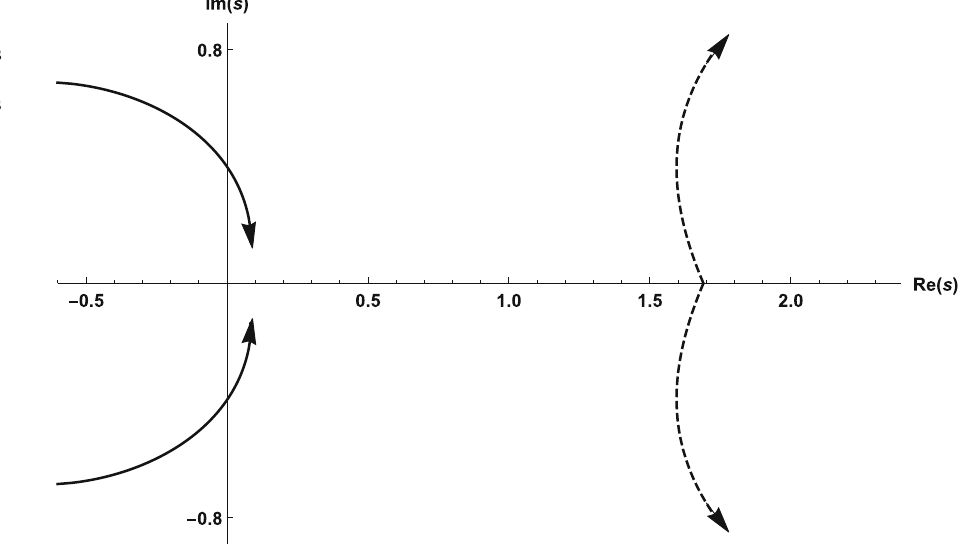
Fig. 4 Trajectories of the two poles related to the lightest √ I = 0 ( u ¯ u + d ¯ d )/ 2 bare states on the second sheet of the complex s -plane. As γ increases from 0 to 4 . 3GeV, the bare state will move to the complex plane and become a broad resonance. Another pole, which originates from deep in the complex plane, will come to a certain place on the complex s -plane and behave as the f 0 ( 500